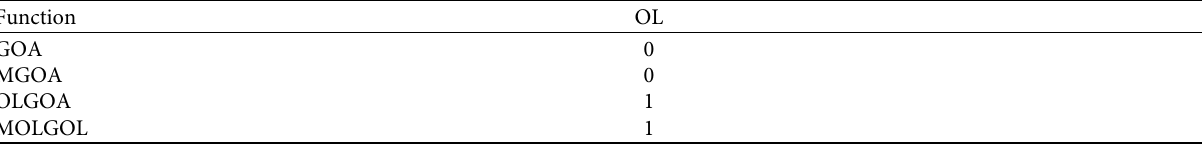
Table 4: Various GOAs with two strategies.